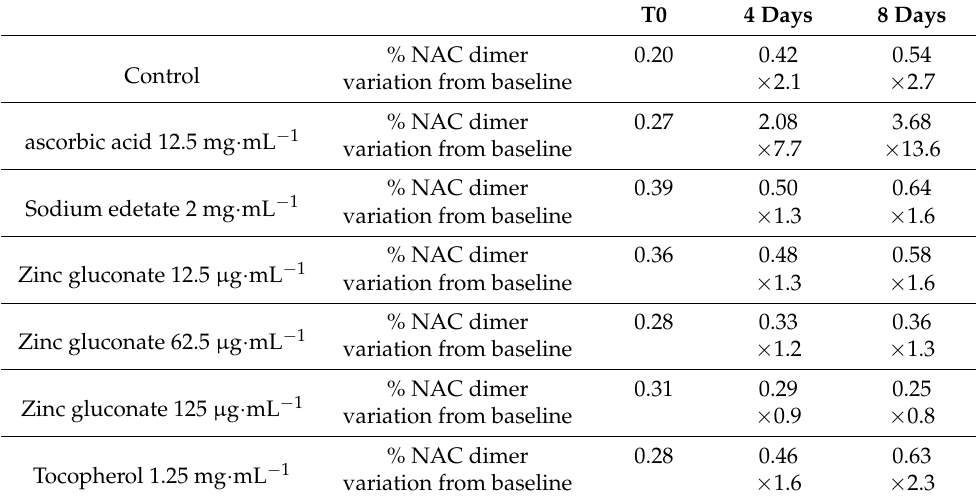
Table 6. Influence of antioxidizing agents on NAC dimerization among